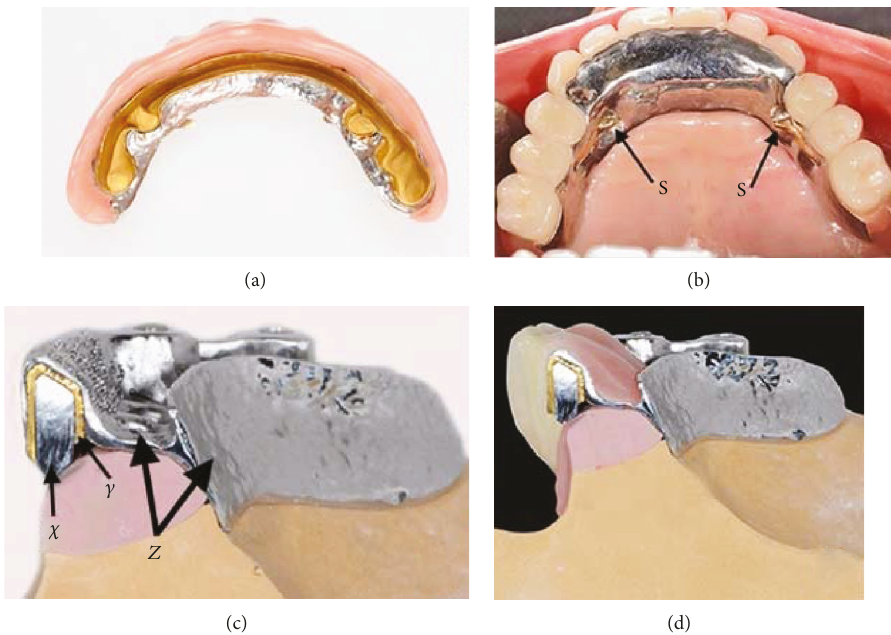
Figure 9: (a) Finished maxillary restoration inner side; (b) maxillary restoration in situ (S: swivel-type lock attachments); (c) cross section of the construction on a model: bar ( X ), ELMES ( Y ), and metal framework ( Z ); (d) the veneered construction. (a, d) Laboratory work shown on a demonstration